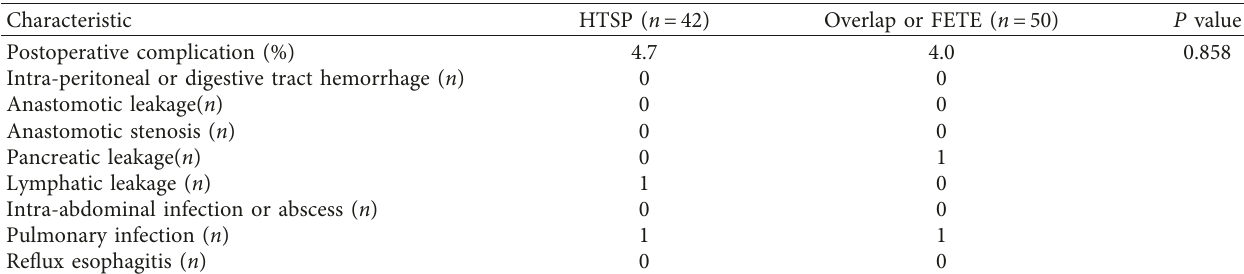
Table 3: Comparison of postoperative complications between half-transected and self-pulling group and traditional anastomosis group in patients with gastric cancer [number (%)]